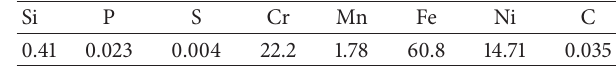
Table 1: Chemical composition (wt.%) of